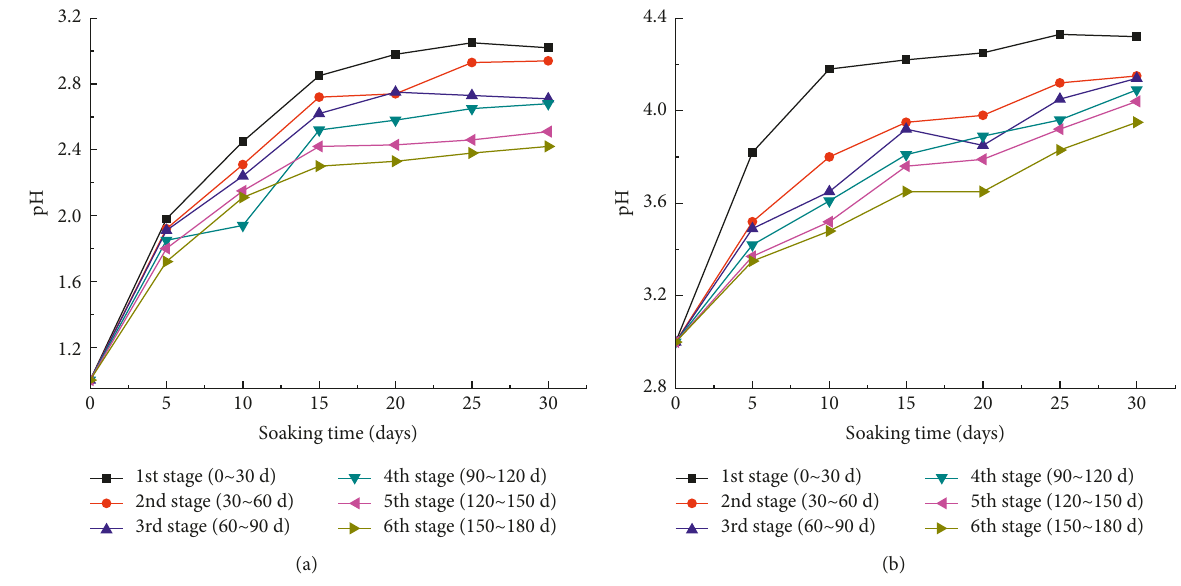
1 and (b) pH 3. (cid:31) (cid:31)